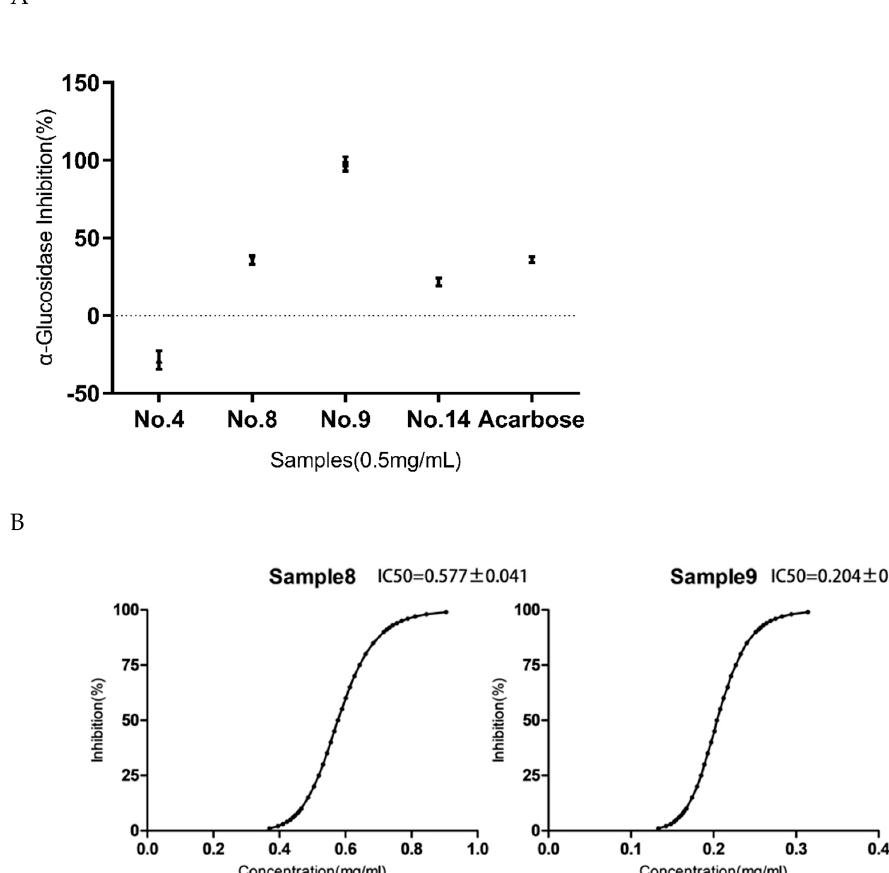
Figure 5. ( A ): Inhibitory effects of the different samples (No.4, 8, 9, and 14) on the α − glucosidase in vitro at the same concentrations (T = 37 ◦ C, pH 6.9); c ( α − glucosidase) = 0.25 U/mL, c (pNPG) = 0.5 mmol/L. ( B ): The value of the half maximal inhibitory concentration (IC 50 ) of the No.8 and No.9 samples was performed by fixing the concentration of the enzyme (0.25 U mL − 1 ) and the substrate pNPG where c ( α − glucosidase) = 0.25 U/mL, c ( p NPG) = 0.5 mmol/L, c (No.8 sample) = 0.30 to 1.00 mg/mL, and c (No.9 sample) = 0.10 to 0.35 mg/mL, respectively. The data were expressed as mean ± the SD ( n = 3).